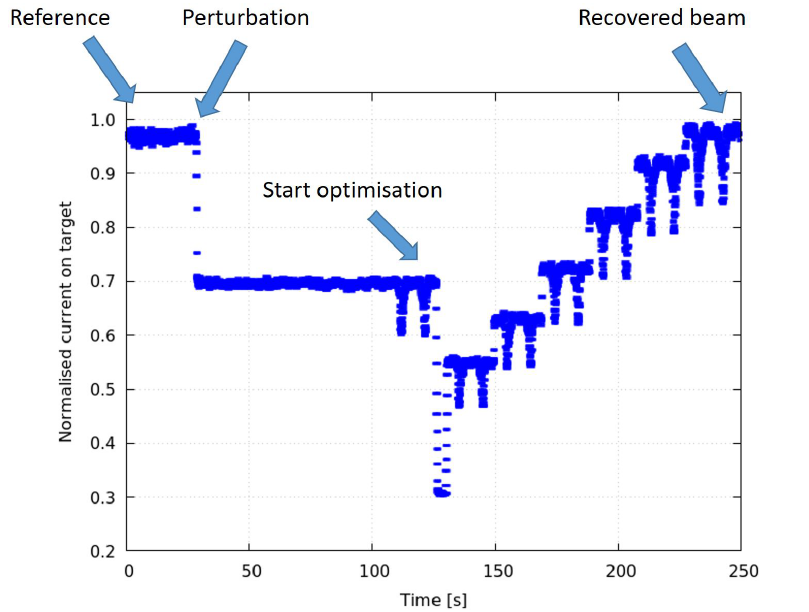
Figure 10. Beam current on target as a function of time during an optimization procedure when a perturbation is applied by means of the quadrupoles of the BTL. The arrows indicate the phases of the